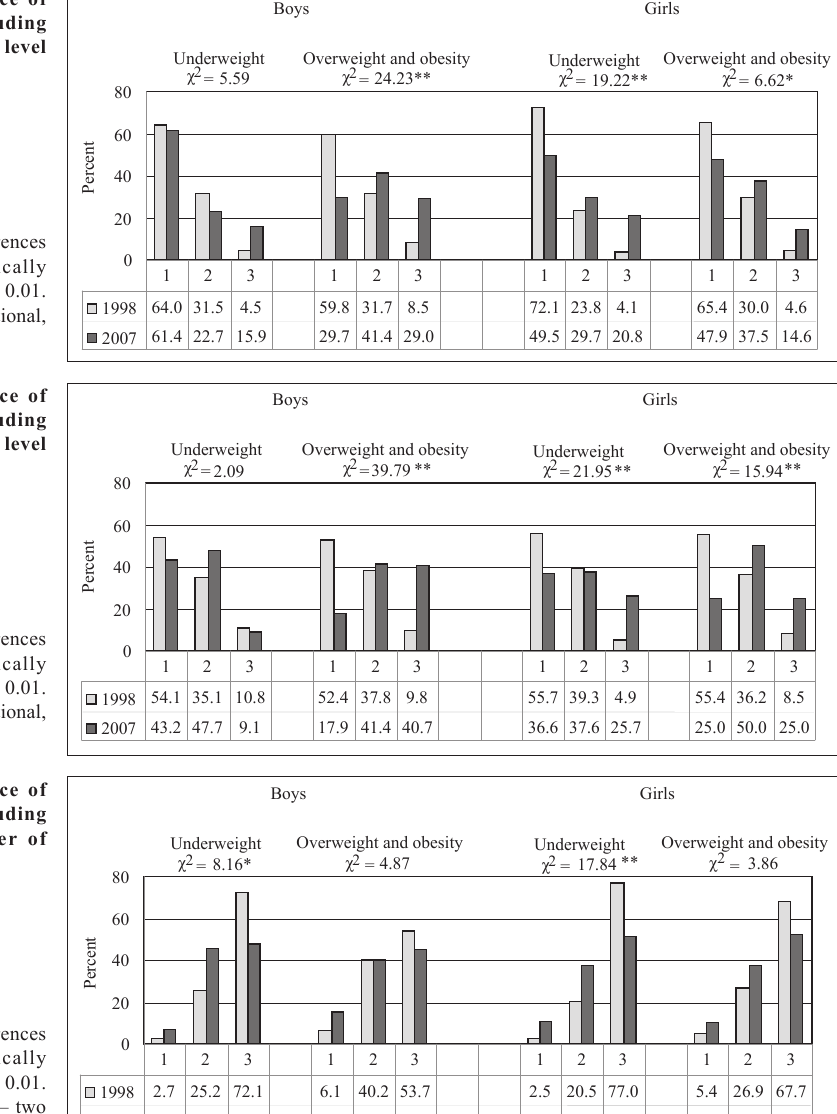
Figure 1. Frequency of occurrence of underweight and overweight including obesity according to the education level of the father